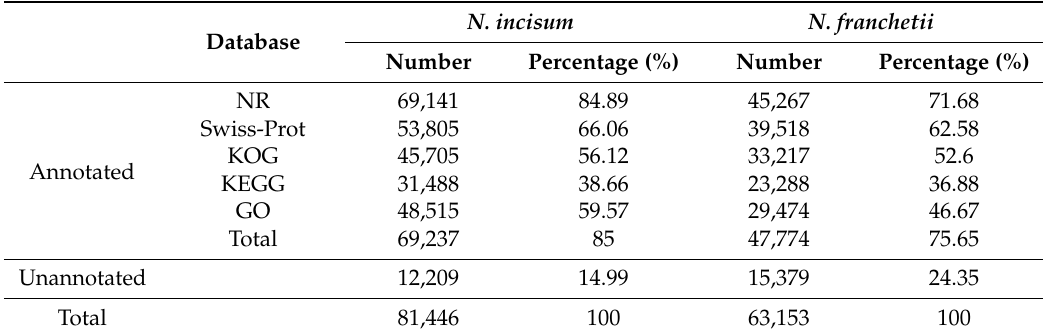
Table 2. Functional annotation of unigenes for Notopterygium incisum and Notopterygium franchetii . N. incisum N.